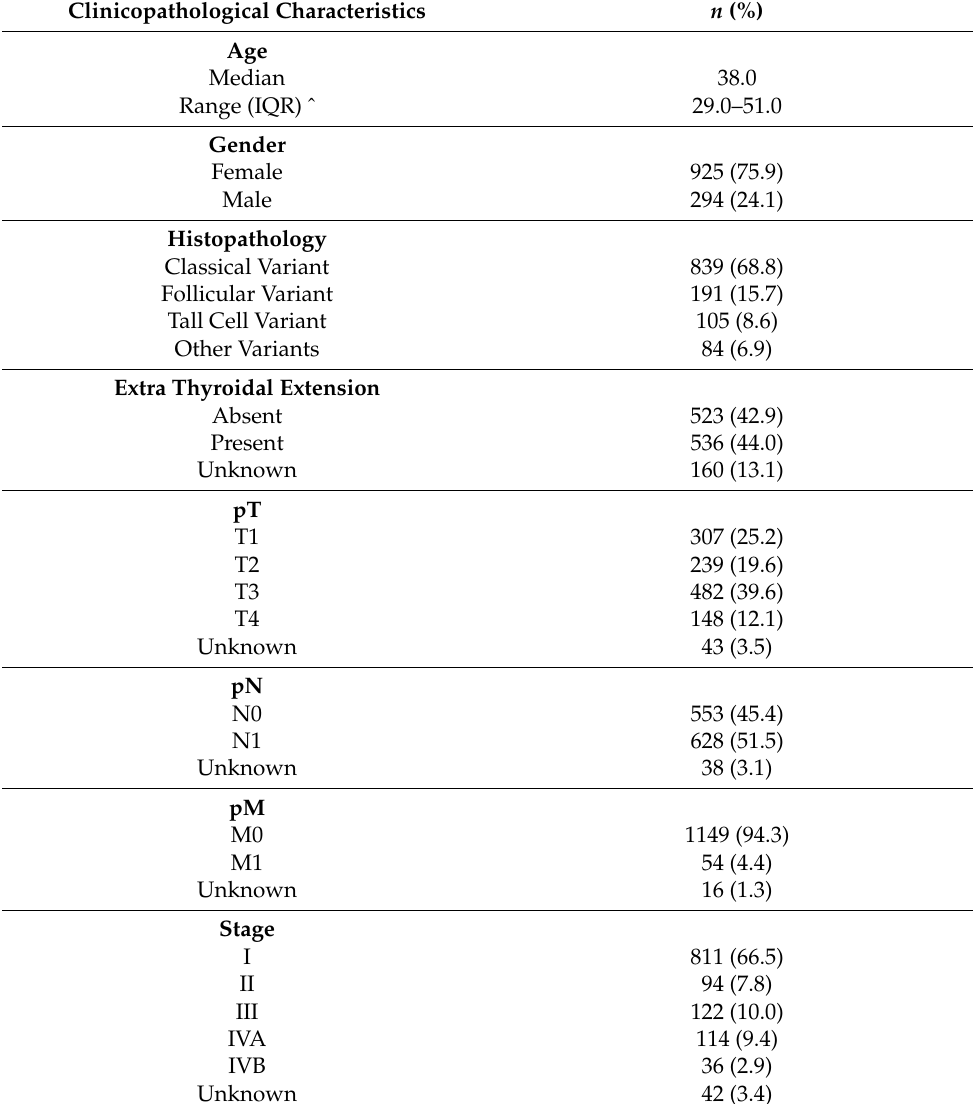
Table 2. Clinico-pathological variables for the patient cohort ( n =